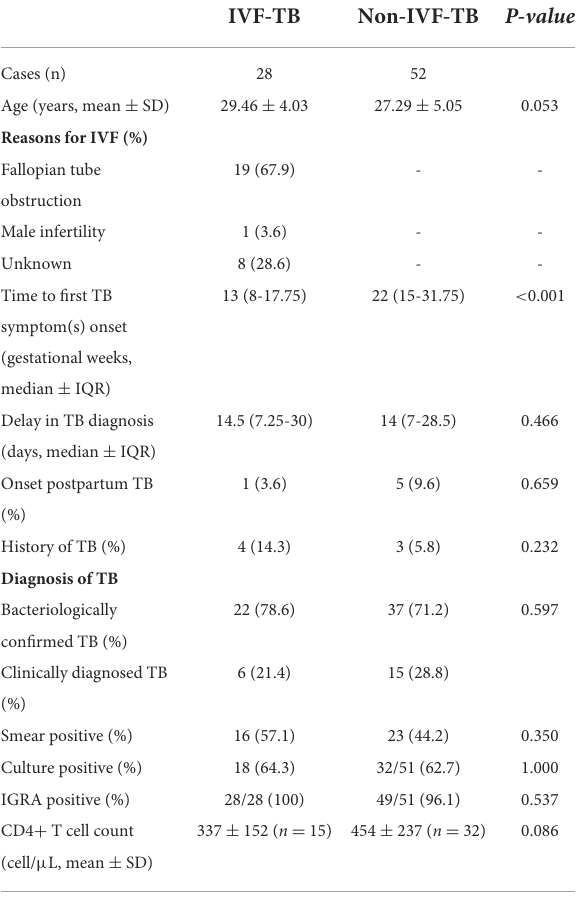
TABLE 1 Characteristics of study